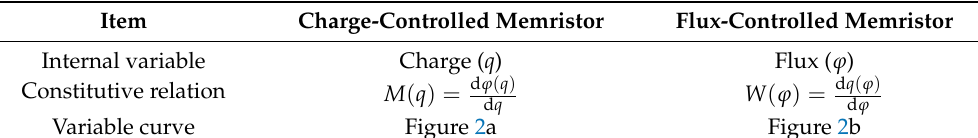
Table 1. Types of memristor.